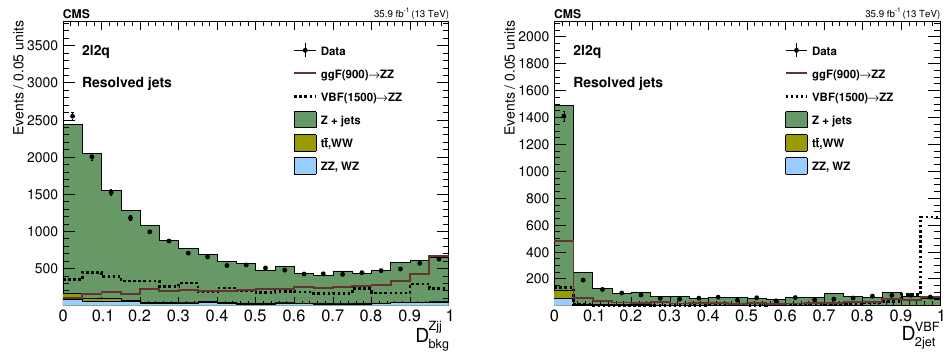
Figure 5 . Distributions of the D Zjj (left) and D VBF (right) discriminants in the signal region for the 2jet bkg resolved selection. The points represent the data, the stacked histograms the expected background from simulation, and the open histograms the expected